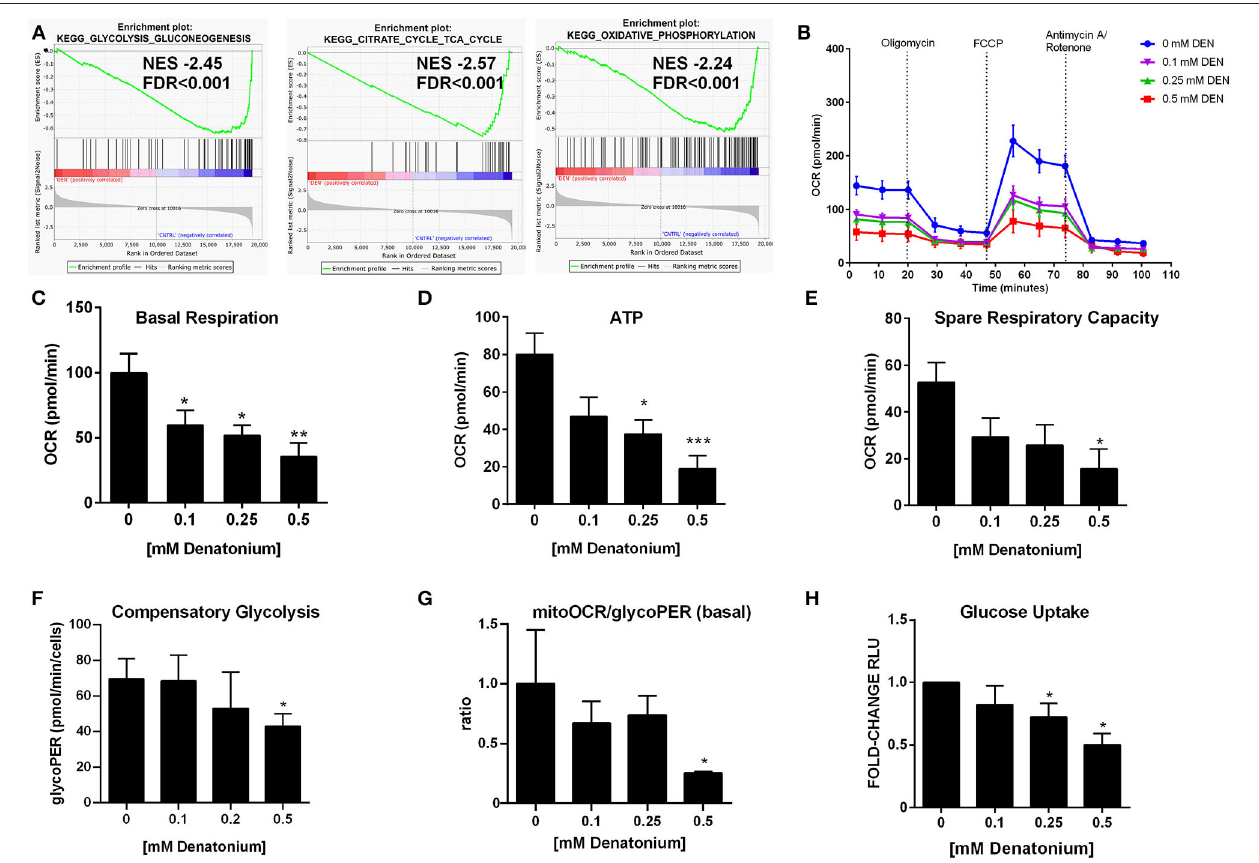
FIGURE 7 | DEN alters mitochondrial bioenergetics. (A) Downregulation of gene signatures of glycolysis, citrate cycle and OXPHOS defined by GSEA in THP1 cells after 24h of exposure to DEN. (B) Oxygen consumption rate (OCR) profile plot obtained by the Seahorse Cell Mito Stress Test in the THP-1 cell ( n = 4) after 24h of exposure to increasing doses of DEN. (C) Basal respiration. (D) ATP-linked respiration. (E) Spare capacity. (F,G) Quantitative data of compensatory glycolysis and ratios of mitochondrial OCR to glycoPER calculated using Seahorse XF Glycolytic Rate assay ( n = 3). (H) Measurement of glucose uptake in THP-1 cells after 24h exposure to increasing doses of DEN ( n = 5). Untreated cells (193,001 ± 44,454 RLU) were used as a reference and set as 1. Data are expressed as mean ± SEM. Statistical analysis was performed by using ANOVA followed by Dunnett’s multiple comparison test with untreated group as control. * p < 0.05; ** p < 0.01; *** p < 0.001. NES, normalized enrichment score; FDR, false discovery